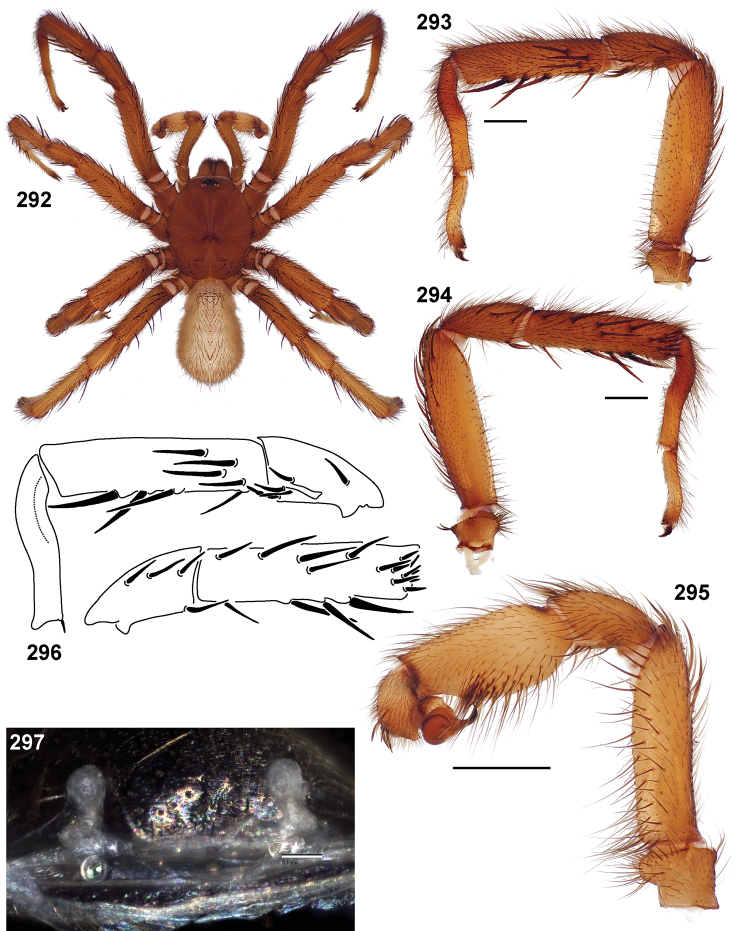
Aptostichus elisabethae sp. n. 292–295 male holotype (AP389) from San Bernardino County; scale bars = 1.0mm 292 habitus [806425] 293 retrolateral aspect, leg I [806429] 294 prolateral aspect, leg I [806431] 295 retrolateral aspect, pedipalp [806433] 296 line drawings of leg I spination pattern; retrolateral aspect patella, tibia, and metatarsus; prolateral aspect, patella and tibia 297 female paratype (AP1254), cleared spermathecae [806434]; scale bar = 0.1mm.